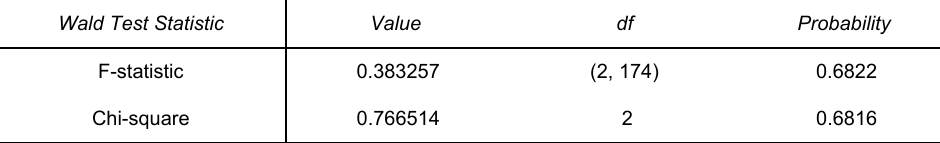
Table 9: Short run causality between GDP and Urban population growth